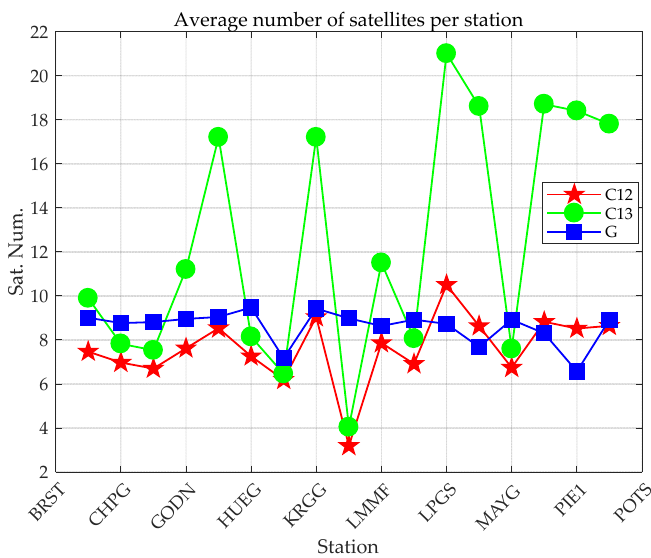
Figure 2. Average number of satellites participating in PPP at 17 stations. For the overall performance of static PPP, due to the limited number of satellites, there are large errors, which have a great impact on positioning statistics and lack statistical objectivity. Figure 3 shows the static PPP error at station PIE1 for BDS-2+3 (B1IB3I), and the number of satellites involved in positioning on DOY 343 in 2020. In Figure 3, there are less than five satellites participating in static PPP for a long time, and the position information cannot be calculated in static PPP.